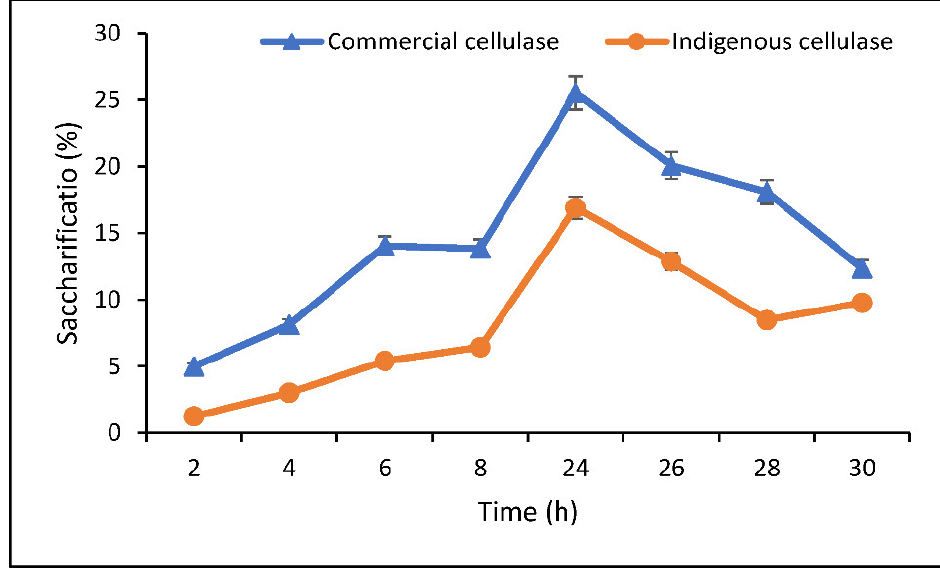
Figure 5. Optimization of time (h) for saccharification.